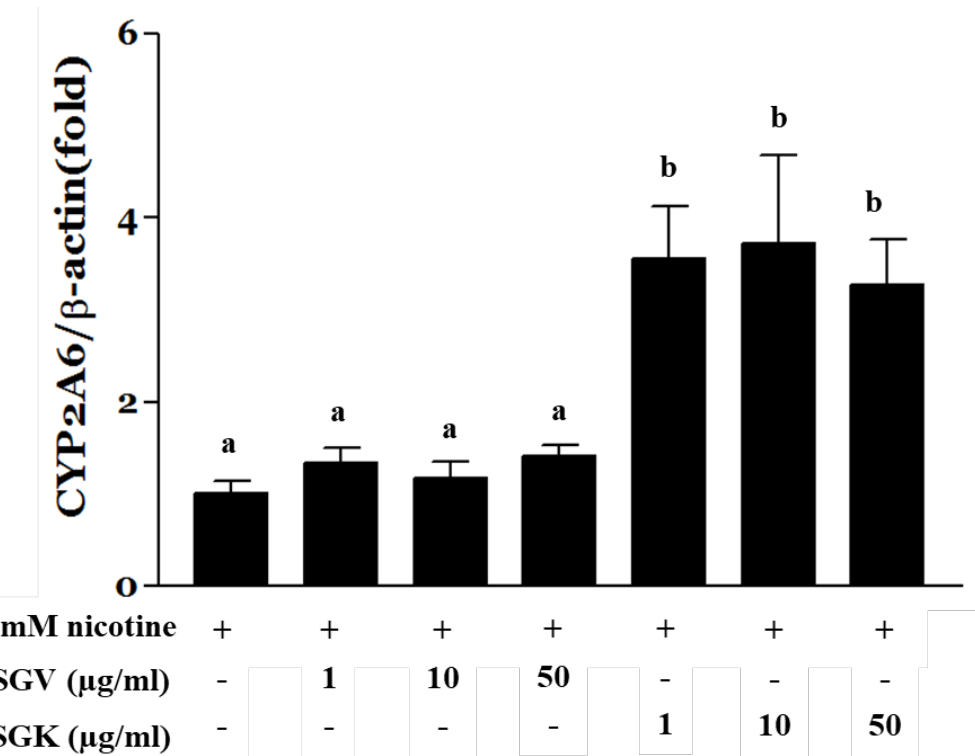
Figure 7. HepG2 cells were treated with 1 mM nicotine for 24 h after pre-treatment with SGV or SGK at various concentrations for 4 h. Total RNA was isolated and real-time PCR was done to measure the expression of CYP2A6. Expression was normalized to β-actin. The data were expressed by mean ± SEM. Different letters represent a significant difference at p < 0.05. + means with treatment and - means without treatment.